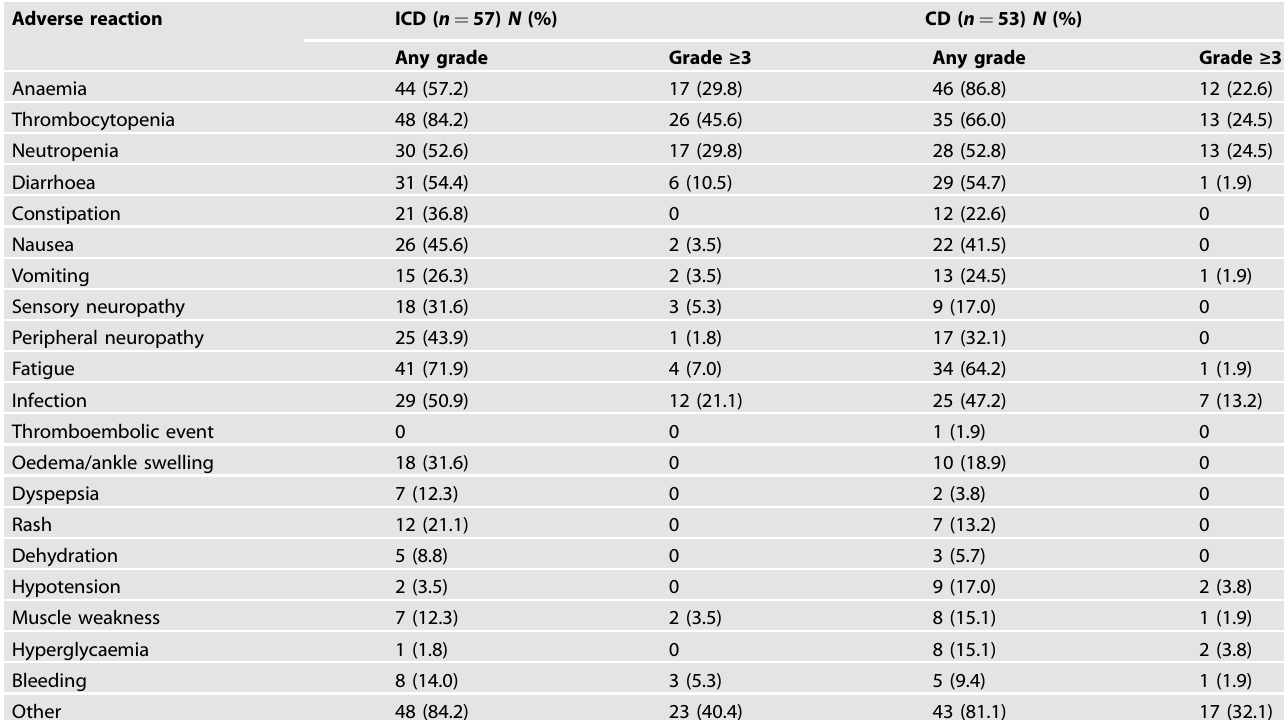
Table 4. Adverse